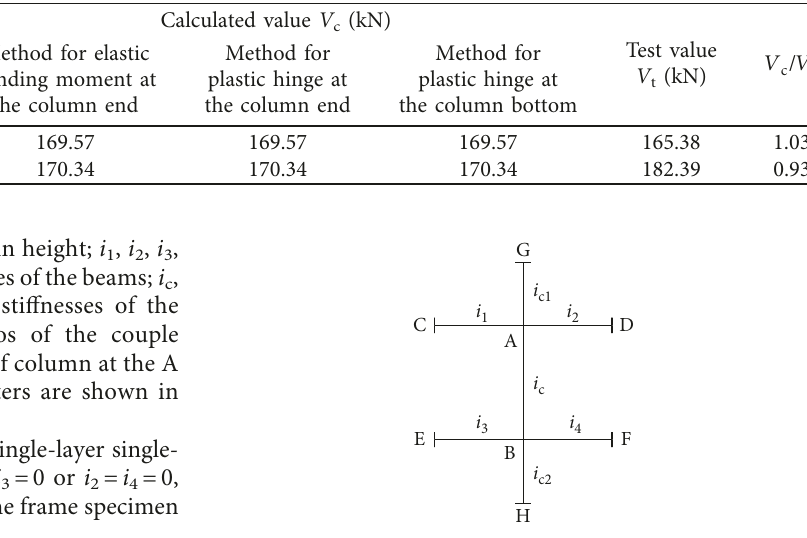
Table 2: Comparison between calculated values and test values of story shear bearing capacity for RACFST frames.